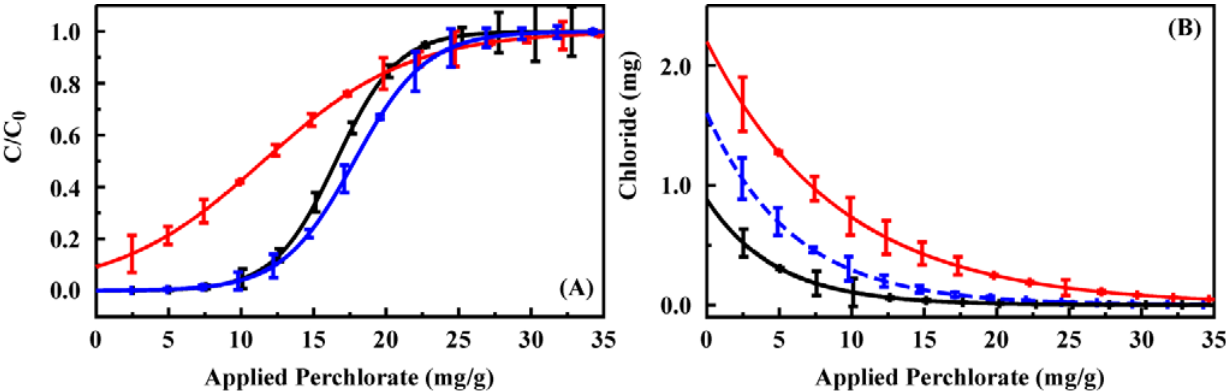
Figure 4. ( A ) Perchlorate breakthrough for 200 mg columns of CF4M (solid), CF2-4M (red), and CF3-4M (blue) using a 10 ppm solution at a flow rate of 1 mL/min; ( B ) Chloride recovered in volumes collected during breakthrough experiments. Similar data for a column of Purolite A530E is provided in the Supporting Information, Figure